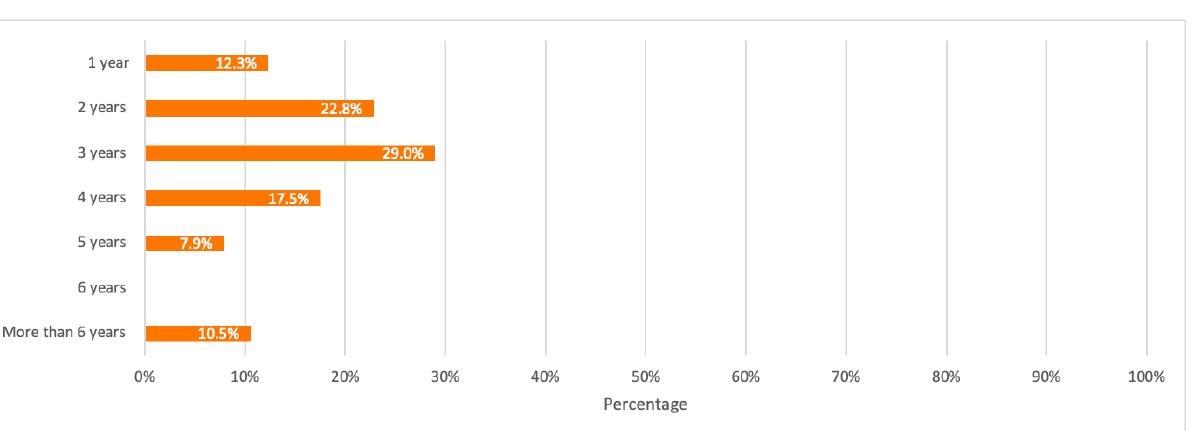
Figure 11. Number of mobile phones currently in-use by households. Figure 12. Respondents’ mobile phones active -use duration.